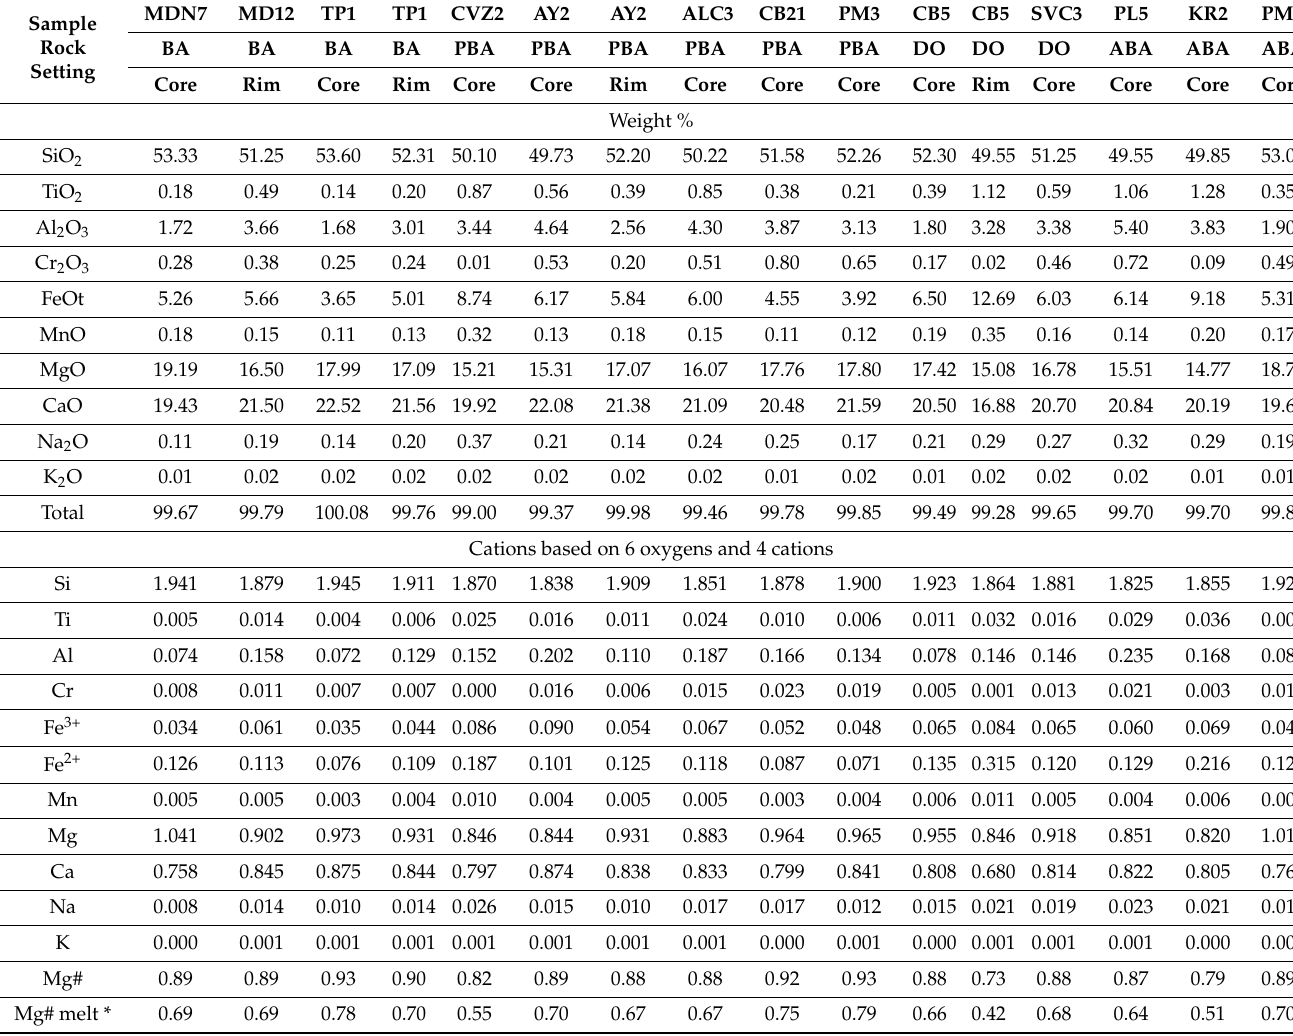
Table 1. Selected representative electron microprobe analyses of clinopyroxene from the different basic rocks from the Yüksekova Complex (E